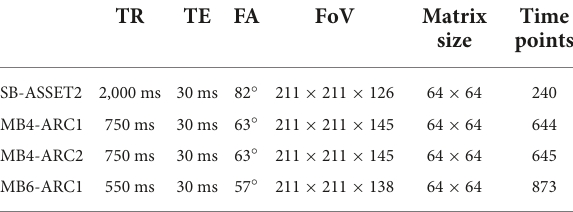
TABLE 1 Parameters of resting-state fMRI